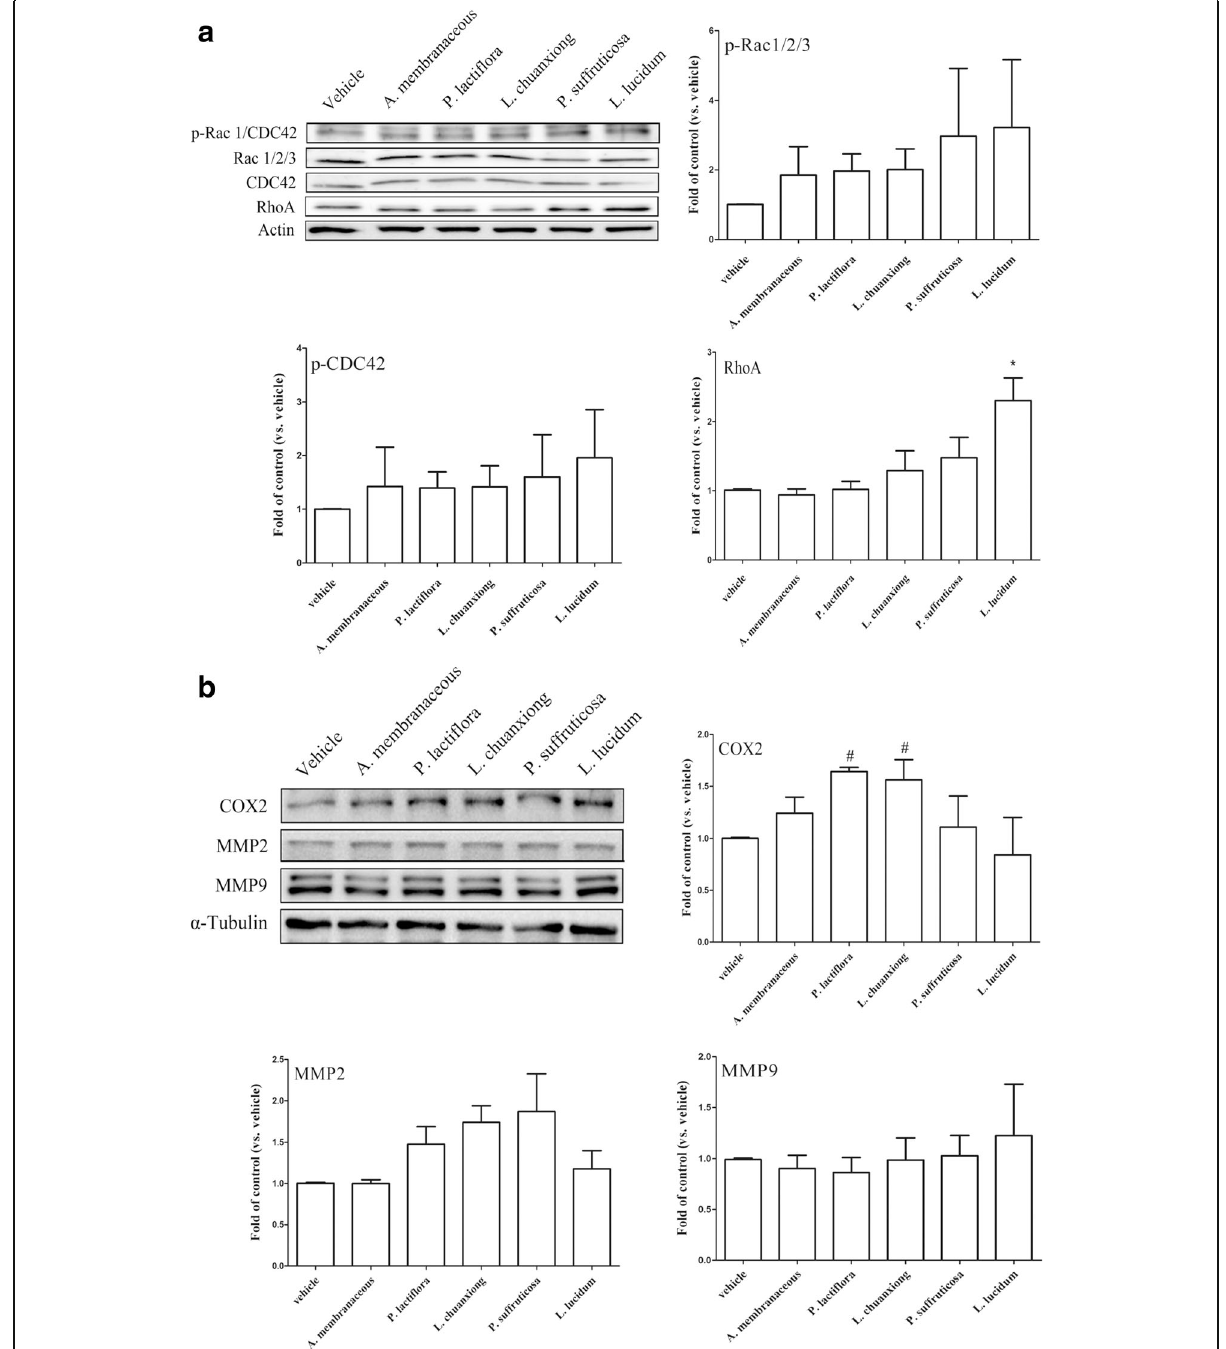
Fig. 8 The effects of Chinese herbal extracts (CHE) on expression of protein involved in migration using HUVEC cells. Cultured HUVEC cells without/ with CHE (1 μ g/mL for each herbal extract) pretreatment were lysed and the expression levels of proteins related to migration, such as Rac 1/2/3, CDC42, Rho ( a ), COX2, MMP2 AND MMP9 ( b ), were analyzed by Western blotting. The results are expressed as mean + SEM. *, p < 0.05 compared to the vehicle group by repeatedly measured one way ANOVA; #, p < 0.05 compared to vehicle group by Mann-Whitney U test (n = three to five independent experiments for each